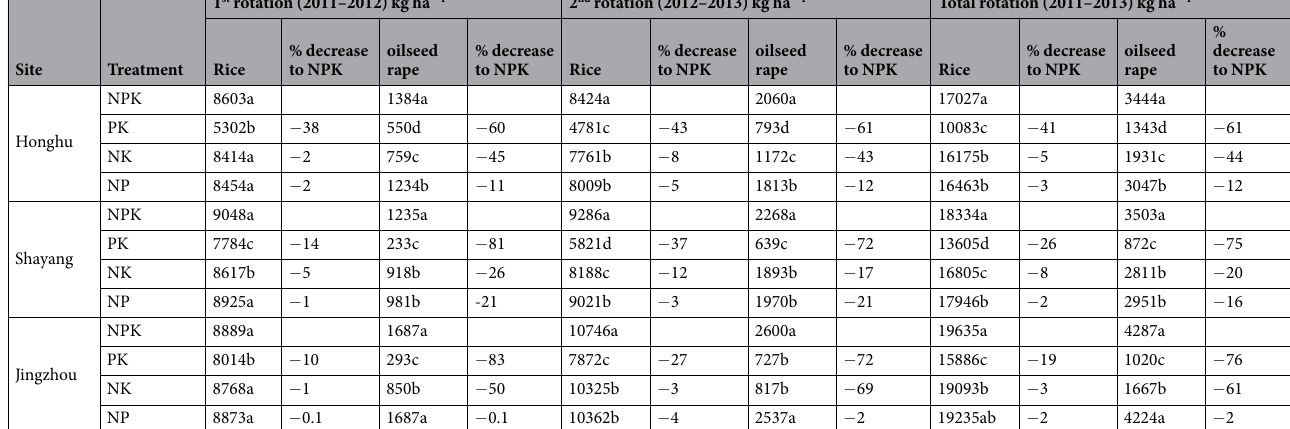
Table 1. Grain and seed yield (kg ha − 1 ) of rice and oilseed rape in different sites of Hubei province affected by with and without NPK fertilization. Mean values within a column for each season followed by different letters are significantly different at P < 0.05 according to